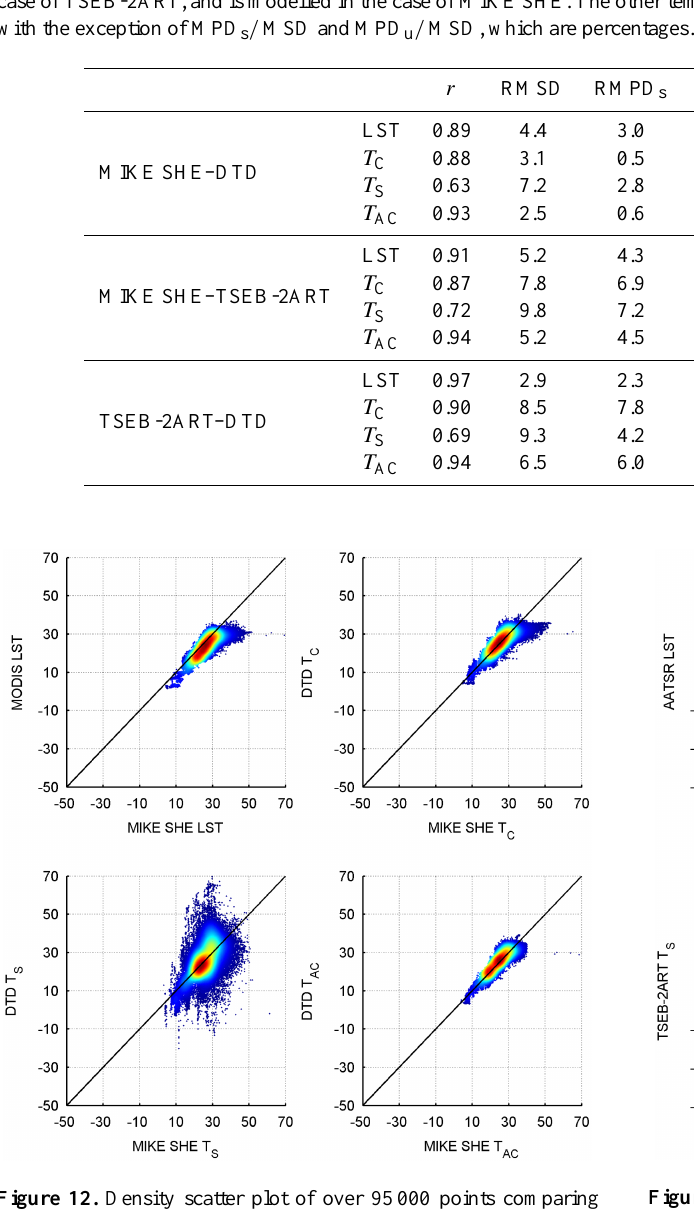
Figure 12. Density scatter plot of over 95000 points comparing land surface temperature (top left), canopy temperature (top right), soil temperature (bottom left) and in-canopy air temperature (bot- tom right). Land surface temperature on the x axis was modelled by MIKE SHE and on the y axis came from daytime observations from the MYD11A1 MODIS product. The other temperatures were modelled by both MIKE SHE and DTD. Red colour indicates higher density of points, blue colour lower density.